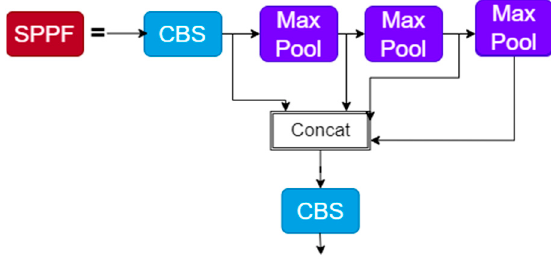
Figure 4. The structure of SPPF.